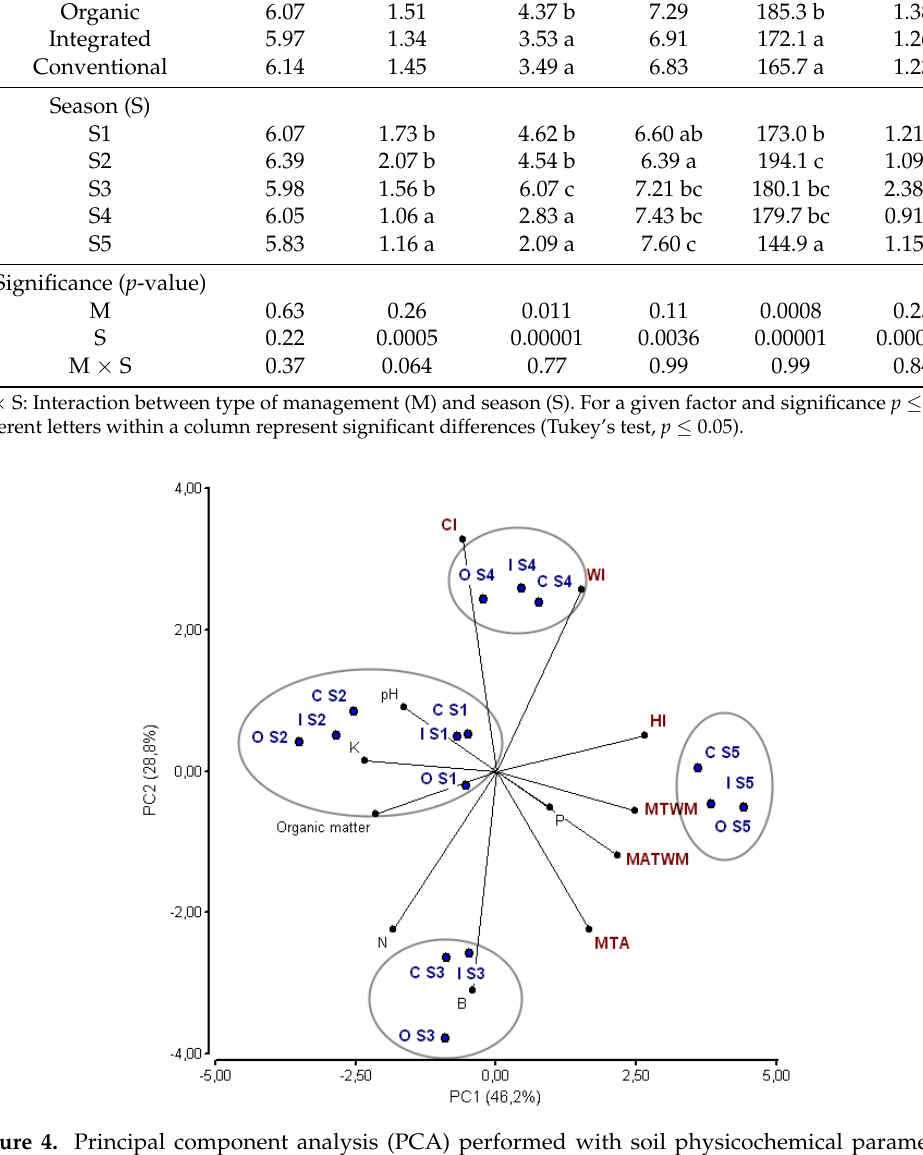
Figure 4. Principal component analysis (PCA) performed with soil physicochemical parameters obtained from Cabernet Sauvignon vineyard planted in an organic (O), integrated (I), and conventional (C) managements, together with different bioclimatic indices such as cool night index (CI), Huglin’s Heliothermal Index (HI), mean thermal amplitude (MTA), Winkler Index (WI), average mean temperature of the warmest month (MTWM), and maximum average temperature of the warmest month (MATWM) along five consecutive seasons